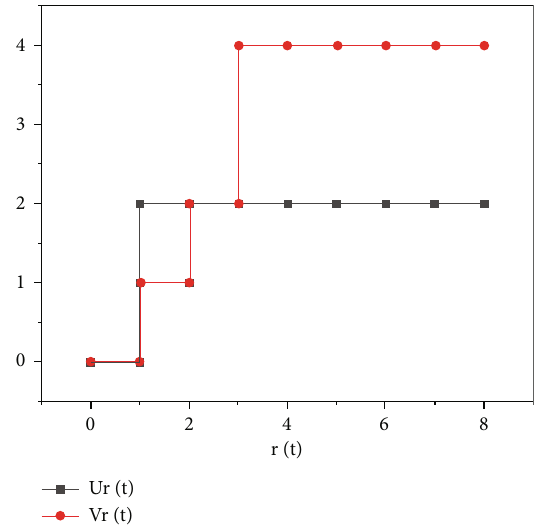
Figure 1: Graphical solution of the Example